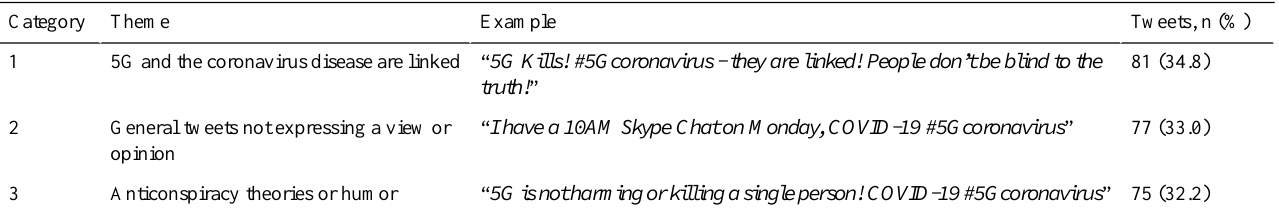
Table 3. Content analysis of individual tweets